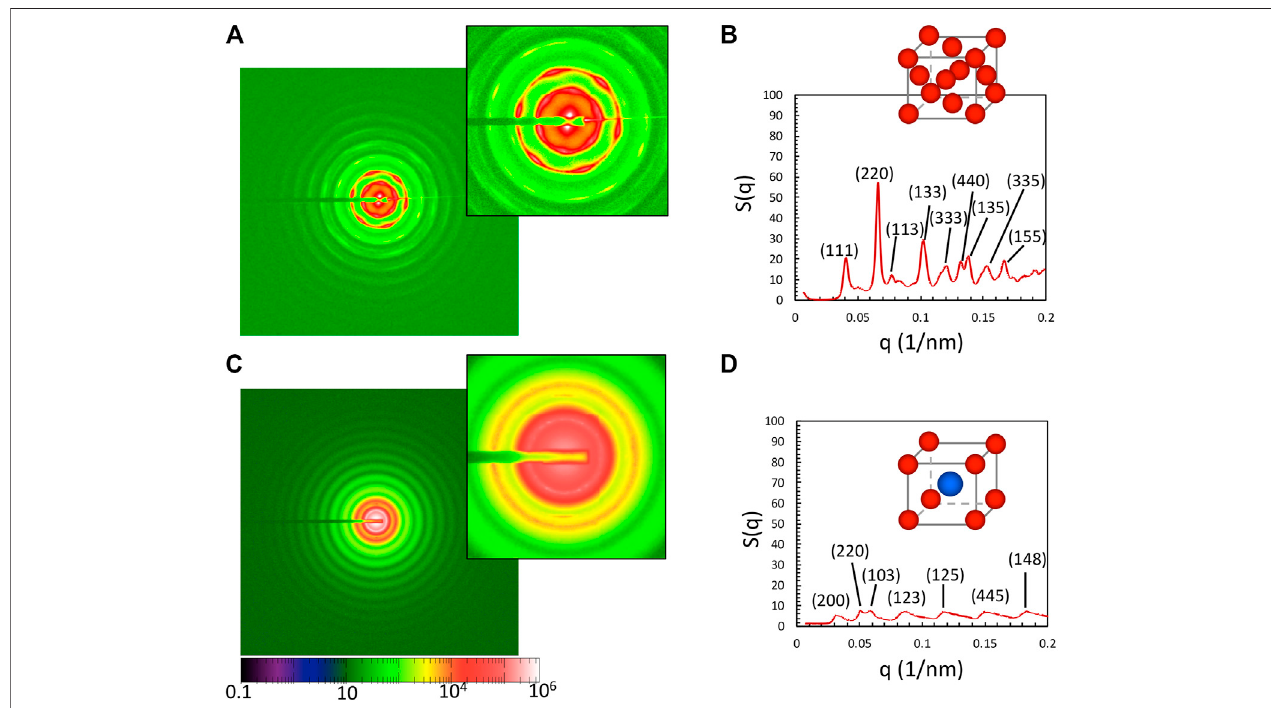
FIGURE3|(A) SAXSspectrumtakenofa30 % FLparticlesuspension. (B) Azimuthallyintegratedstructurefactorofthissample,afterdividingbytheformfactoras measured in a 0.1 % suspension. The peaks are assigned to the corresponding Miller indices (hkl). (C) Corresponding SAXS and (D) integrated spectrum of the 1:1 mixture made of FL and PS particles.